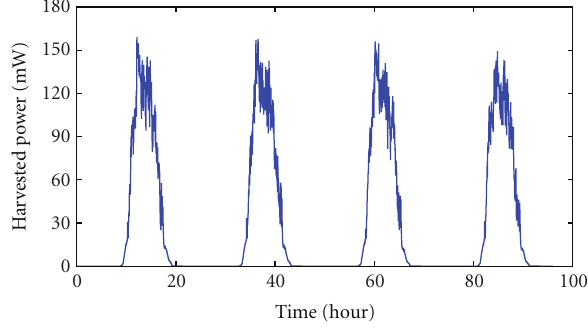
Figure 12: Harvested power over 4 days.